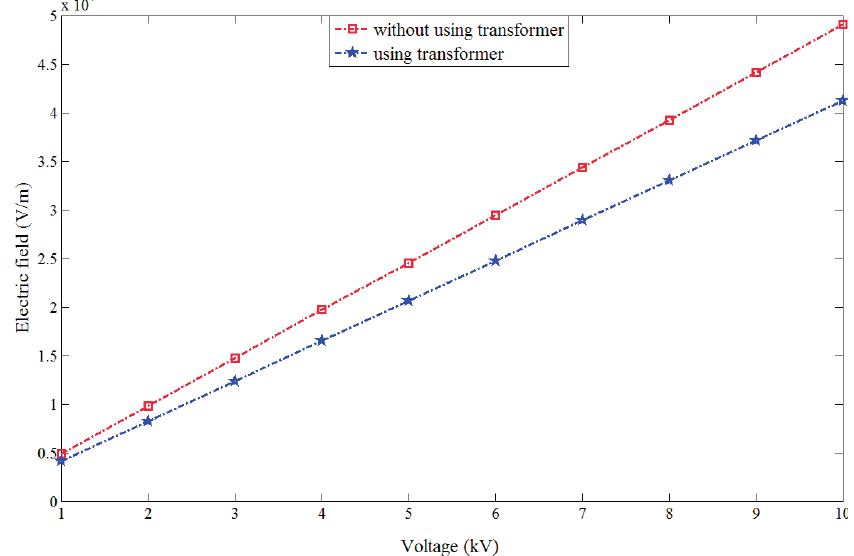
Figure 11. Change of electric field intensity with voltage